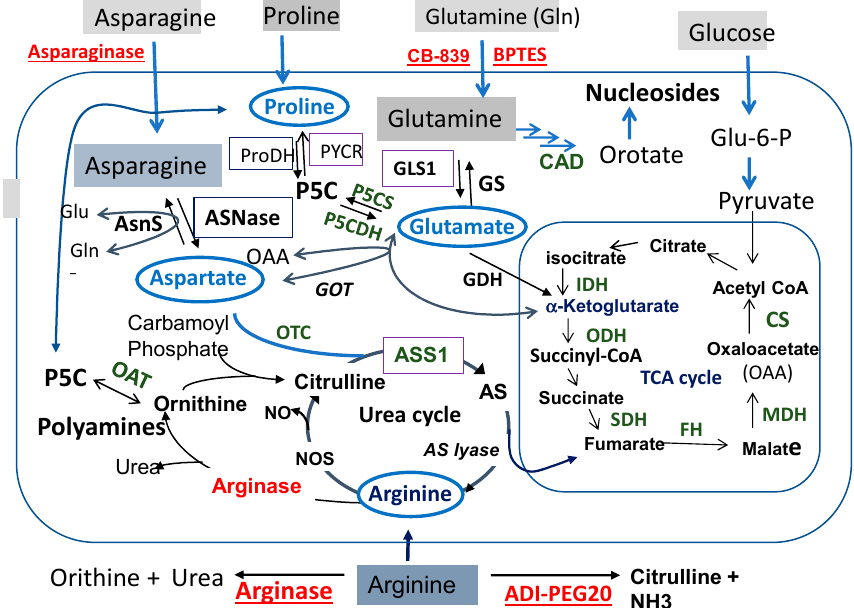
Figure 1. Metabolic pathways linking proline (Pro), glutamine (Glu), arginine (Arg), and asparagine (Asn). Abbreviations: AS, argininosuccinate; ASNase, asparaginase; AsnS, asparagine synthetase; ASS1; argininosuccinate synthetase 1; GDH, glutamine dehydrogenase; glutamic-oxaloacetic transaminase 1; FH, fumarate hydratase; GLS, glutaminase; GS, glutamine synthetase; GOT, glutamic oxaloacetic transaminase 1; GDH, glutamine dehydrogenase; NOS, nitric oxide synthetase; OAA, oxaloacetate; OAT, Ornithine aminotransferase; OTC, ornithine transcarbamylase; P5C, pyrroline 5-carboxylate; ProDH, proline dehydrogenase; PYCR, P5C reductase. Agents used for treatments are underlined and in red; the enzymes in the pathways that have been considered as targets for therapies are boxed. CAD represents three major enzymatic steps in the biosynthesis of nucleosides from glutamine, i.e., carbamoyl phosphate synthetase-II (CPS-II), aspartate transcarbamylase (ATCase) and Dihydro orotase.